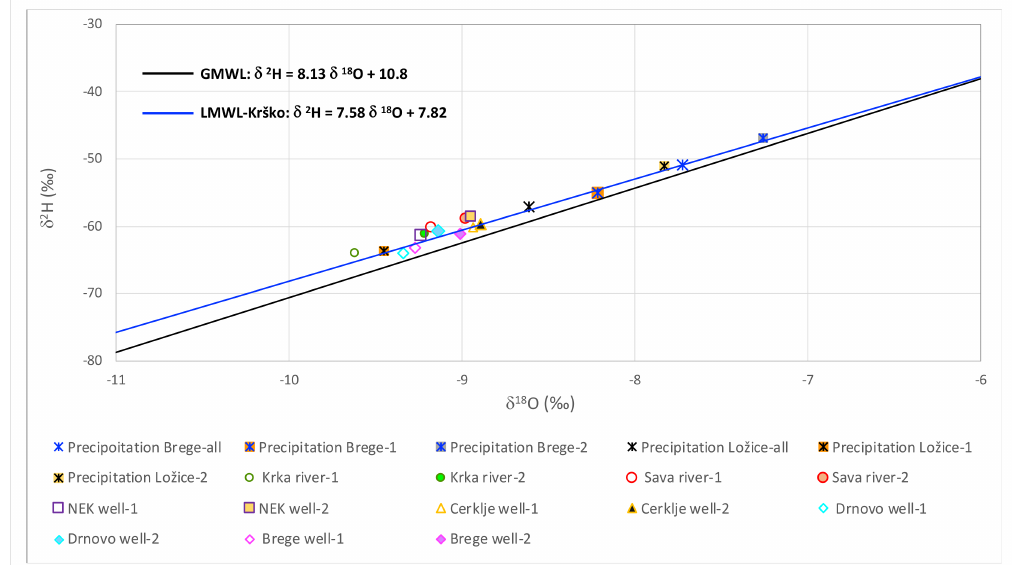
Figure 6. Median values of δ 18 O and δ 2 H in surface water and groundwater, and weighted averages of δ 18 O and δ 2 H in precipitation before (number 1 next to sample name) and after (number 2 next to sample name) the filling of the accumulation basin for the HPP